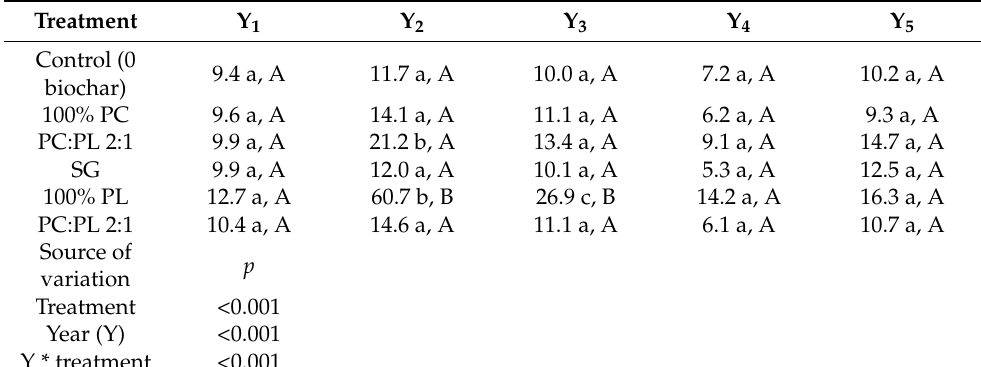
Table 6. Topsoil (0–15 cm deep) Mehlich 1 extractable soil sodium (Na) concentrations in kg ha − 1 by treatment and year (means from n = 4; Y = year; PC = pine chip biochar; PL = poultry litter biochar; SG = switchgrass